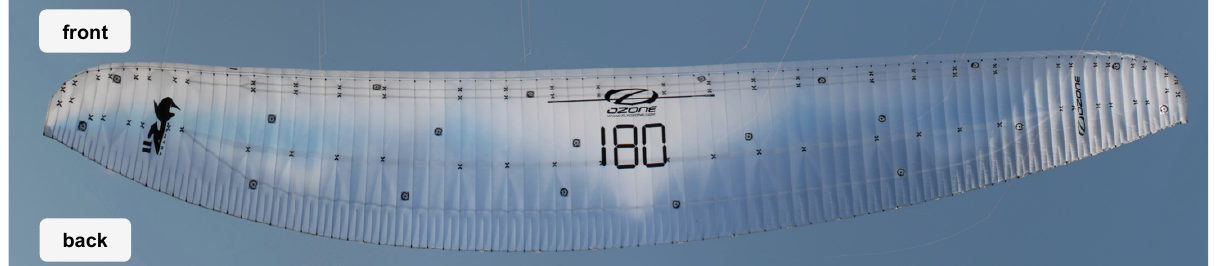
Fig. 6: Panorama image of the entire paraglider